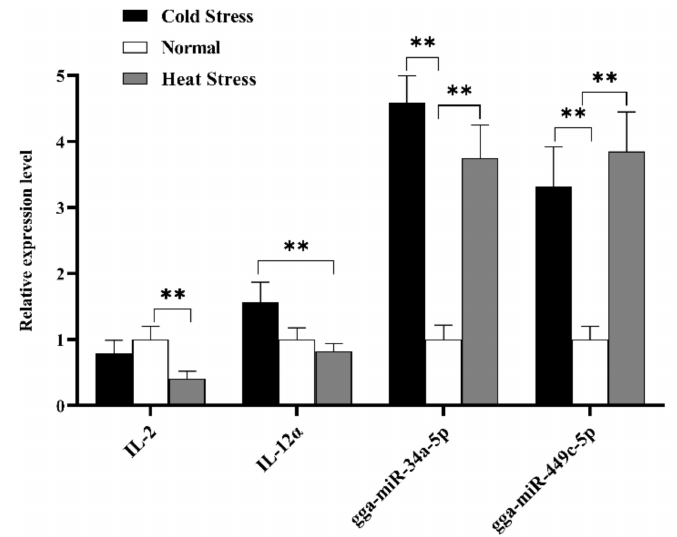
Figure 8. Expression analysis of selected two DEMs and two target genes in splenic tissue of di ff erent broiler (HS, NS, CS) by RT-qPCR methods. The x -axis represents di ff erent miRNA, and the y -axis represents the relative expression level of miRNAs or mRNA targets. Data are presented as mean ± standard error. * on the top of lines or bars indicated a significant di ff erence (** p < 0.05) between heat stressed and normal